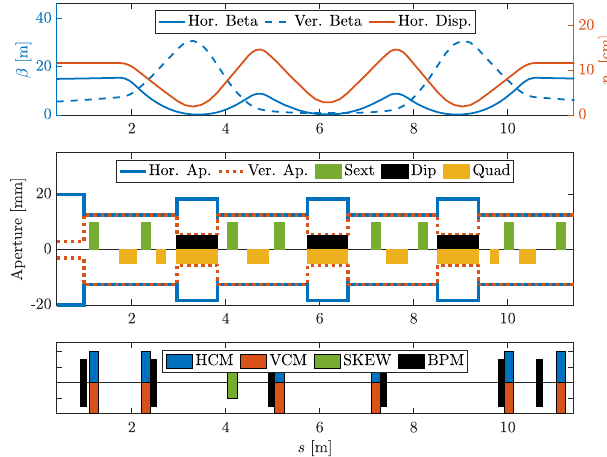
FIG. 4. Lattice and magnet distribution of the first sector of the ALS-U AR. Shown are the beta and the dispersion functions (top), the aperture model and the distribution of magnets (center) and the distribution of CMs, skew quadrupole correctors and BPMs (bottom). Note that the length of the magnets is to scale.